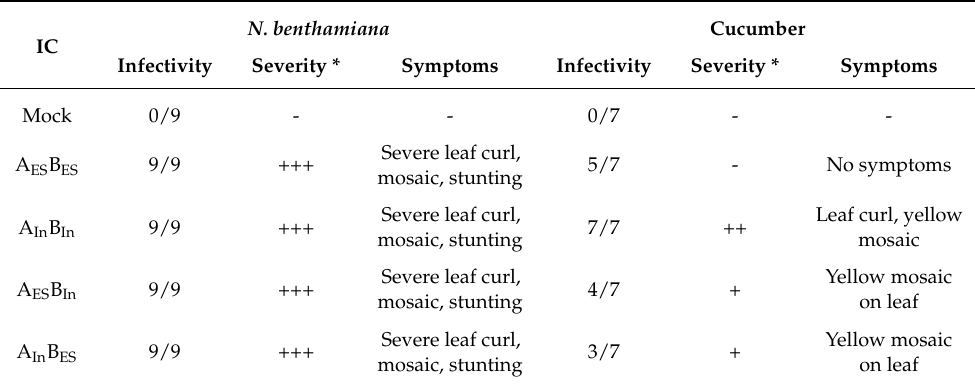
* Severity: -: infected but no symptom, +: infected and show 1 symptom, ++: infected and show 2 symptom, +++: infected and show 3 symptom.